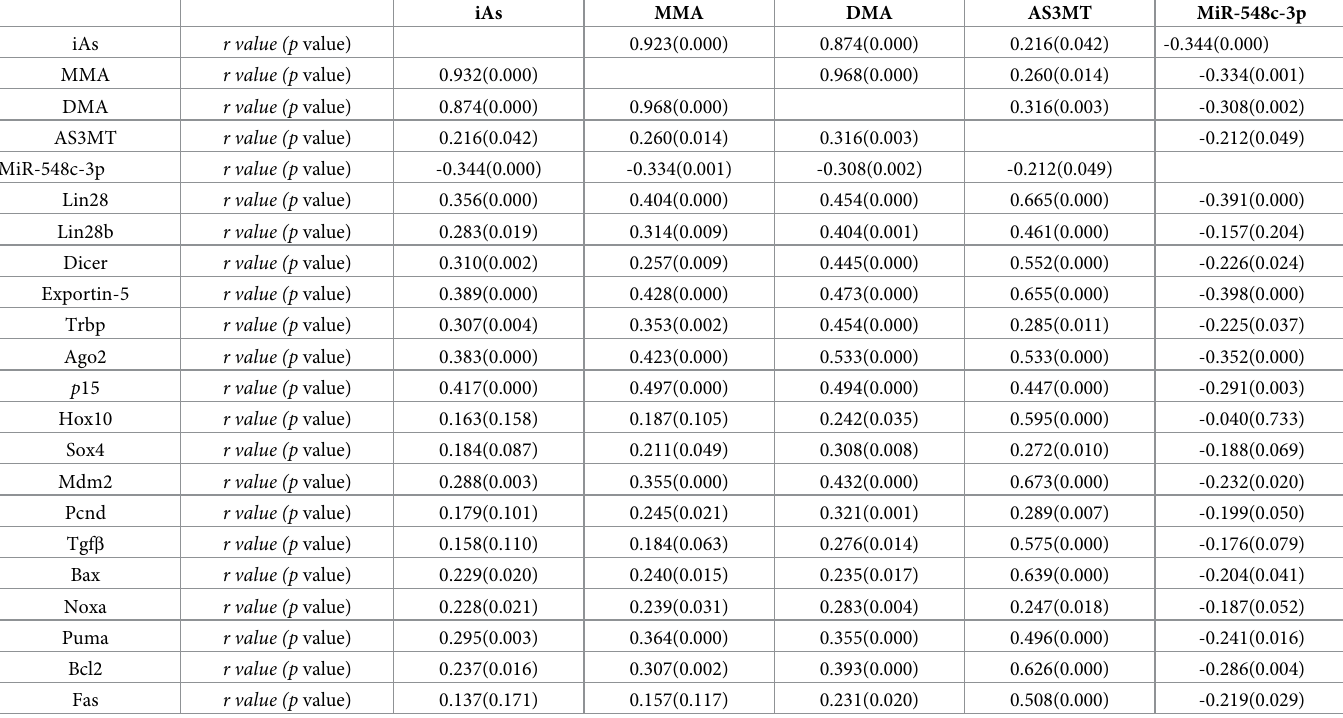
Table 2. Spearman’s rank correlation analysis along arsenic species, MiR-5 48c-3p , AS3MT and relative